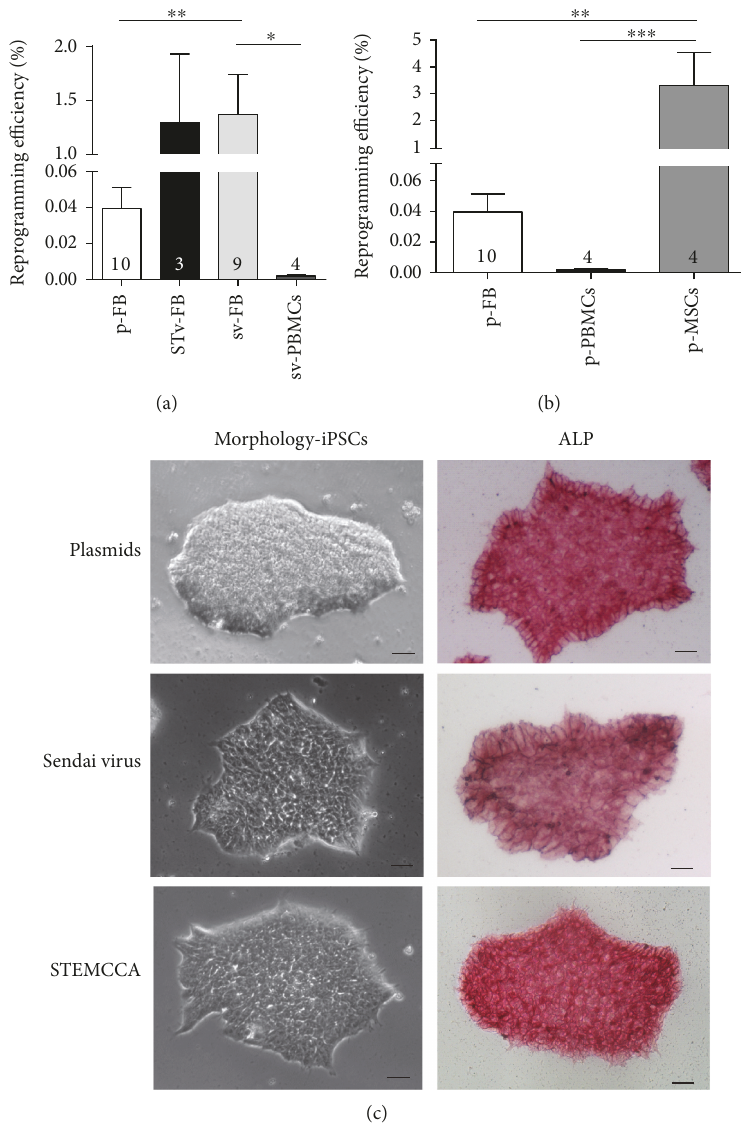
Figure 1: Generation and characteristics of hiPSCs derived from skin fi broblasts (FB). (a) Reprogramming e ffi ciency for generation of PMBC-hiPSCs and FB-hiPSCs based on di ff erent reprogramming methods. Reprogramming e ffi ciency was evaluated as total iPSC colonies obtained up to day 25 from 4.8 to 40 × 10 4 starting FB (dependent on the used method); n = 10 (p-FB =plasmids), n = 3 (STv- FB =STEMCCA), and n = 9 (sv-FB =Sendai virus). 3 × 10 5 PBMCs were used for reprogramming by sv; n = 4 (sv-PBMCs). ∗ P ≤ 0 05 ; ∗∗ P ≤ 0 01 . n (numbers) are de fi ned as reprogramming experiments of di ff erent somatic cell sources by the mentioned method. (b) Reprogramming e ffi ciency for generation of FB-iPSCs ( n = 10 ), PBMC-iPSCs ( n = 4 ), and MSC-iPSCs using episomal plasmids. 5 × 10 5 MSCs were used for reprogramming by plasmids; n = 4 . (c) Morphology of iPSCs. iPSCs show human ES-like morphology and are positive for alkaline phosphatase (ALP). Scale bar: 100 μ